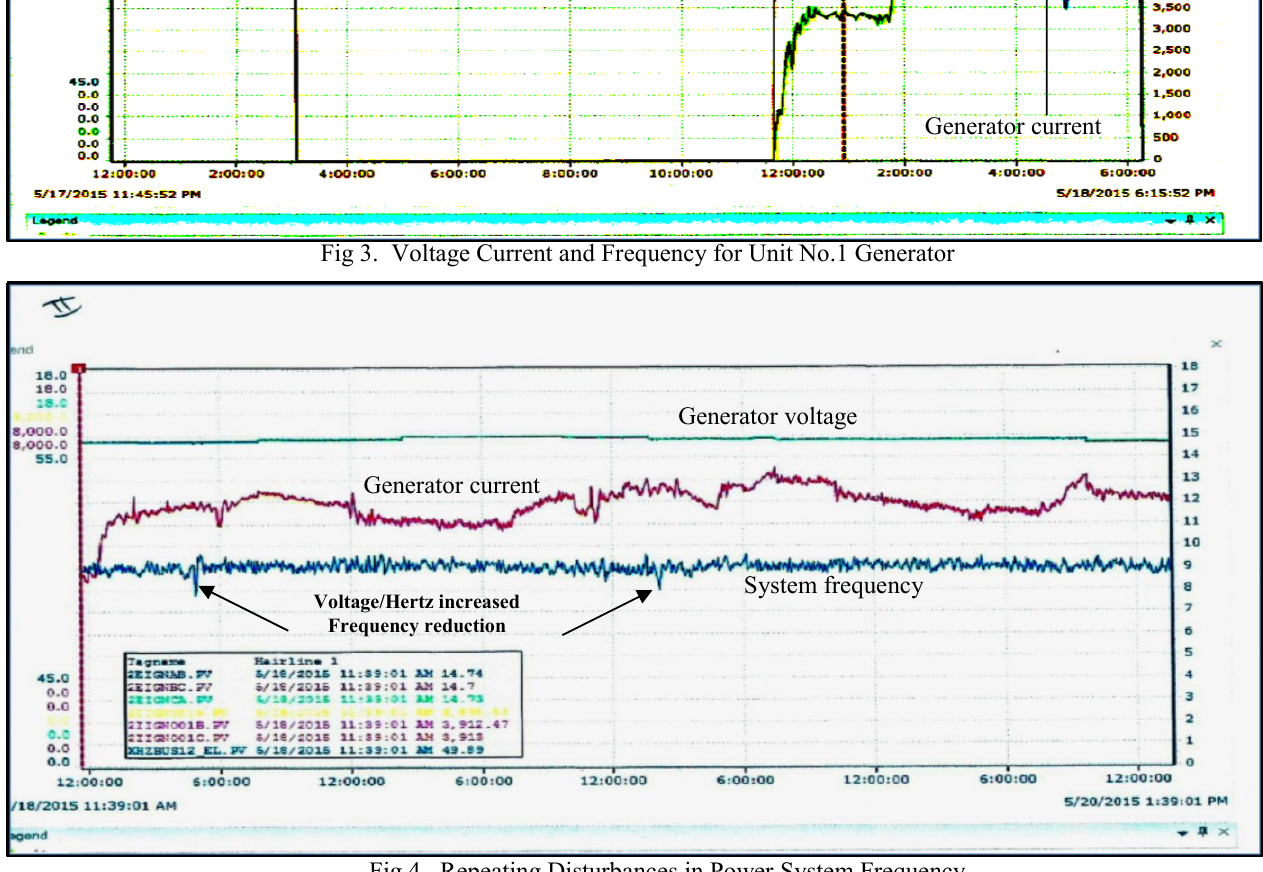
Fig 4. Repeating Disturbances in Power System Frequency